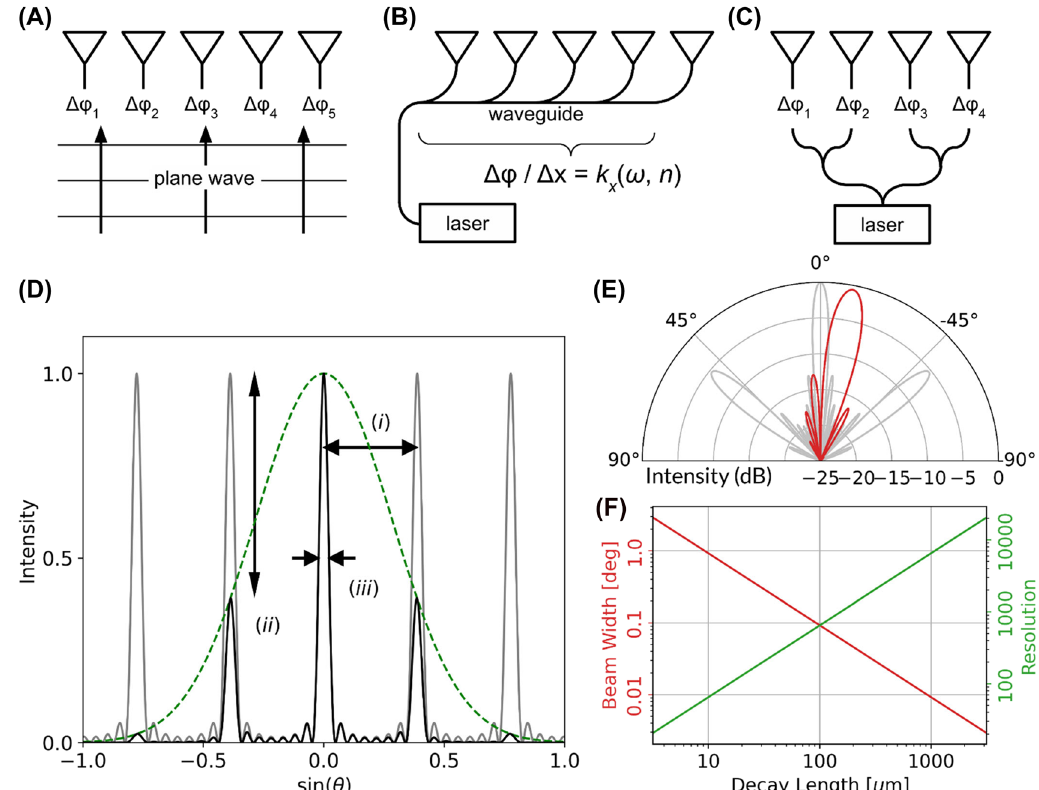
Figure 1: Principles of beam steering with nanophotonics. (A) – (C) Schematics of optical power routing in (A) active metasurfaces, (B) slow-light waveguides and frequency tuned gratings, and (C) integrated optical phased arrays. In (A) – (C), Δ φ , d φ / d x , and k x ( ω , n ) denotes the phase change of each antenna, the spatial phase gradient, and wavenumber, respectively. The wavenumber depends on frequency and material permittivity. (D) showsan exampleof a typical 1Dopticalphasedarrayfar fi eldpattern(FFP)(solidblackline),where(i)indicatestheusable fi eldofview,constrainedherebydiffractionlobes oneither sideof the mainlobe, (ii)showsthe side mode suppression ratio(SMSR)quanti fi edhere bythe ratioof main lobepowerto sidelobe power, and (iii) shows the beam width. The dashed green line shows the emission pattern of a single antenna, enveloping the array ’ s far fi eld diffractionpattern(solidgreyline).In(E),thered(grey)plotillustratestheFFPofan8-antennaarraywithantennaspacingsmaller(larger)than half wavelength, showing undesirable grating lobes produced by an insuf fi ciently compact array. (F) For grating-like beam steering (B), the lower right plot shows at example of the longitudinal divergence angle and resolution versus decay length at 1550 nm with 60 °